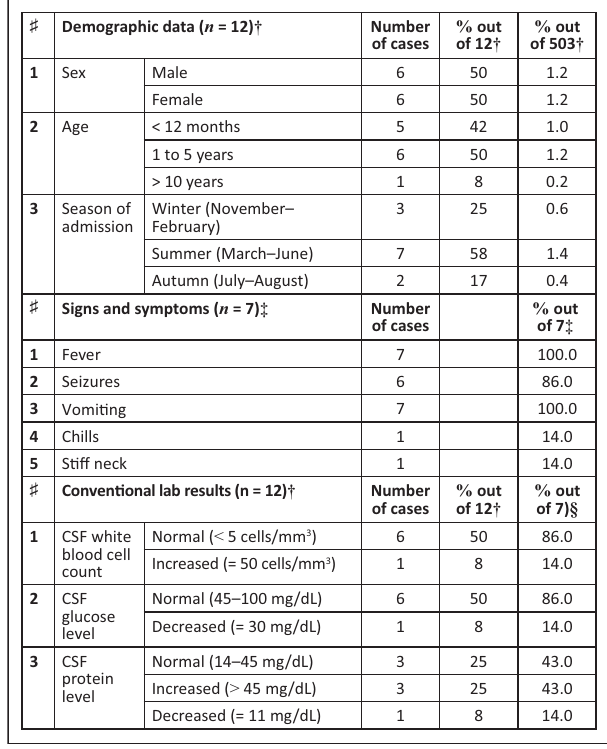
FIGURE 2: Demographic, clinical and conventional laboratory data for Human Herpes Virus type-6 positive patients, Khartoum, Sudan,